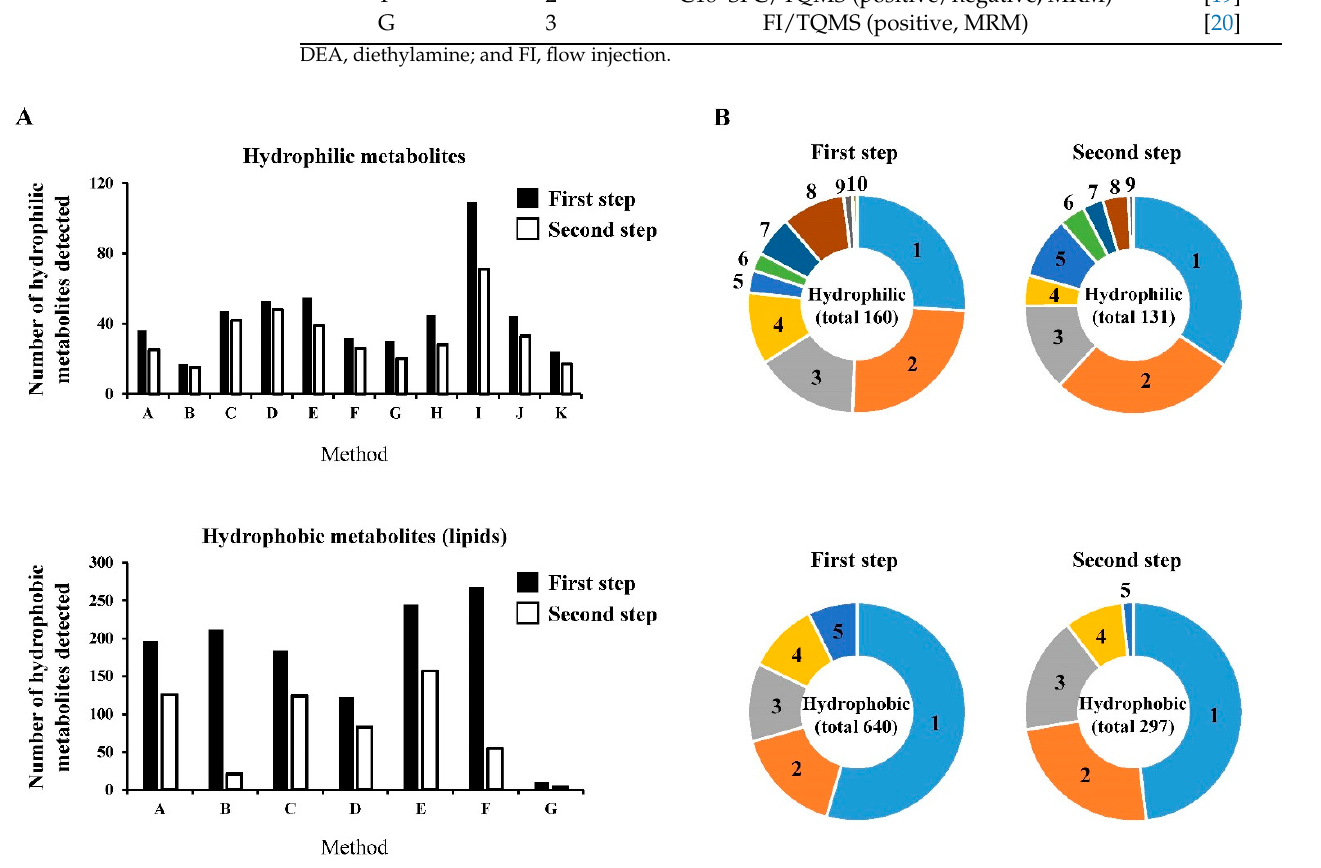
Figure 2. Number of metabolites detected by each analytical method and the percentages of the metabolites measured in common by multiple methods: ( A ) the numbers of metabolites detected by each analytical method for the hydrophilic or hydrophobic metabolites are shown; ( B ) the percentages of metabolites commonly measured by multiple methods are shown using pie charts. In the first step, 160 hydrophilic metabolites and 640 hydrophobic metabolites were identified in both human and mouse plasma. In the second step, 113 hydrophilic metabolites and 297 hydrophobic metabolites were identified in both human and mouse plasma.